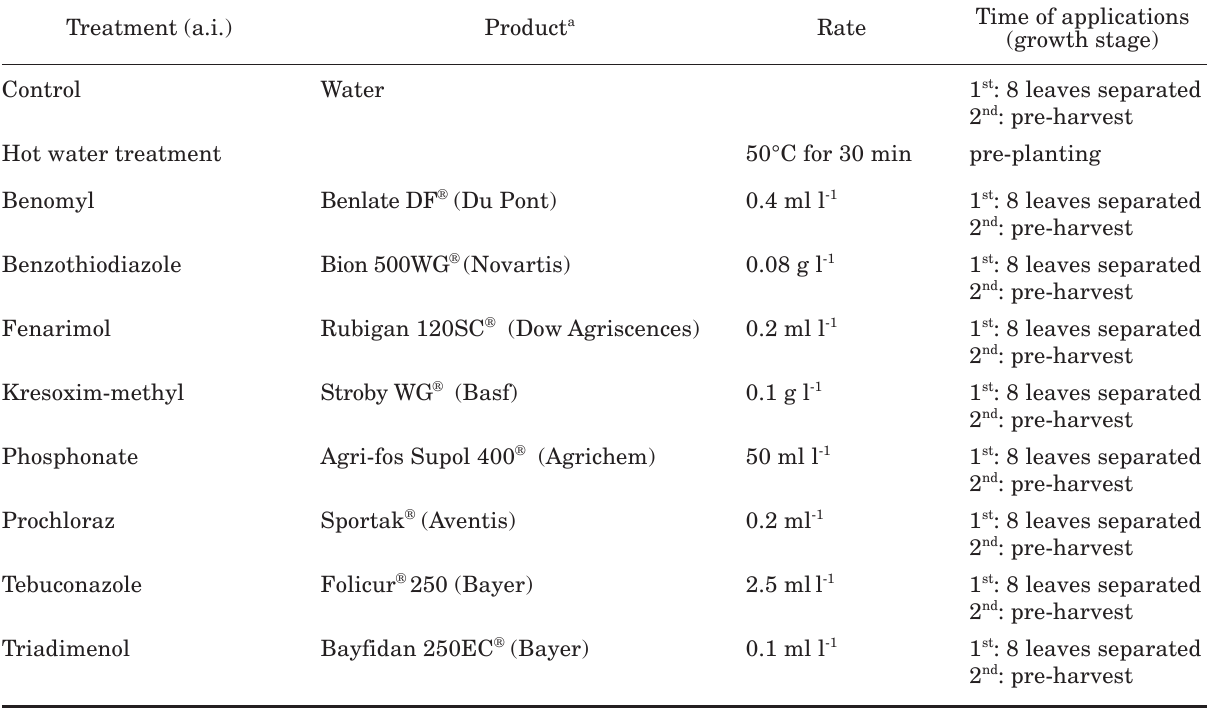
Table 1. Treatments applied to naturally Pch -infected Pinot Noir rootlings. Treatment